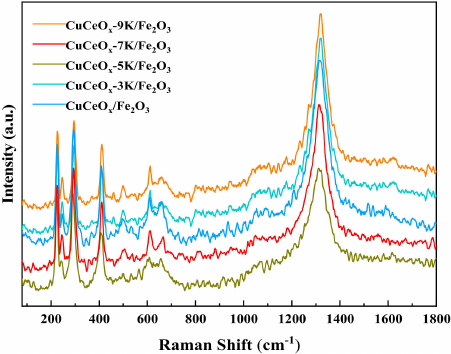
Figure 5. Raman spectrum of the CuCeO x -xK/Fe 2 O 3